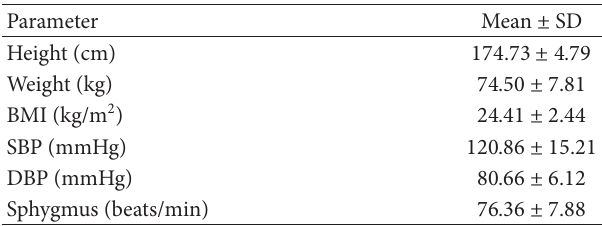
Table 1: Anthropomorphic and cardiovascular characteristics of civil aviators in China in 2006 ( 𝑁 = 305